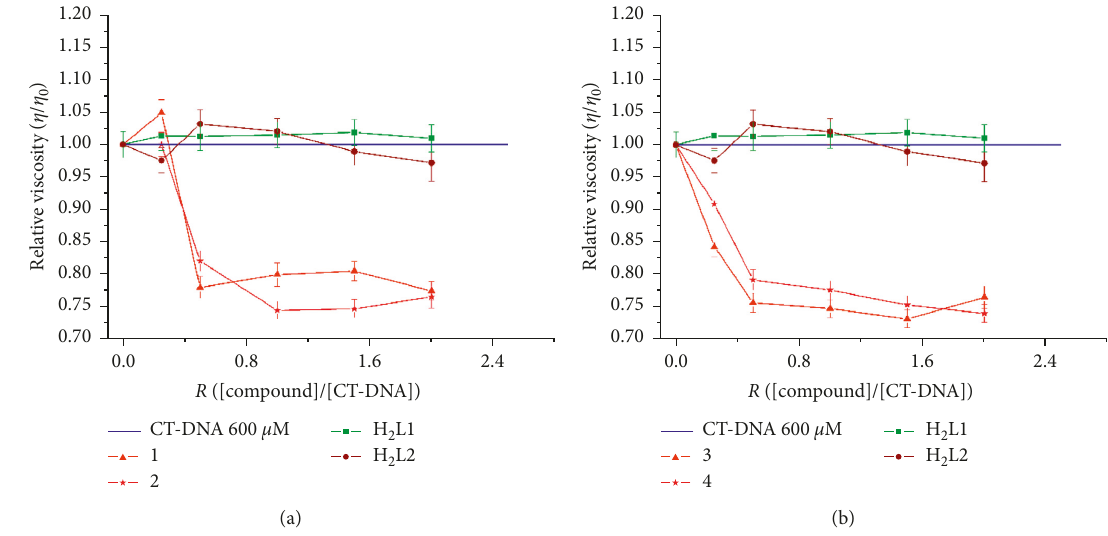
Figure 6: Effect of increasing amounts of compound ( R [compound]/[DNA]) between 0.2 and 2) on the relative viscosities of the CT- (cid:31) DNA solutions at 600 s M (blue line), H 2 L1 (green), and H 2 L2 (brown): (a) 1 and 2 ; (b) 3 and 4 .